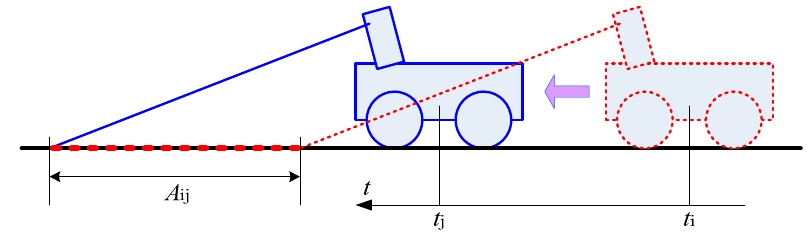
Figure 2. The scanned area in front of the robot.